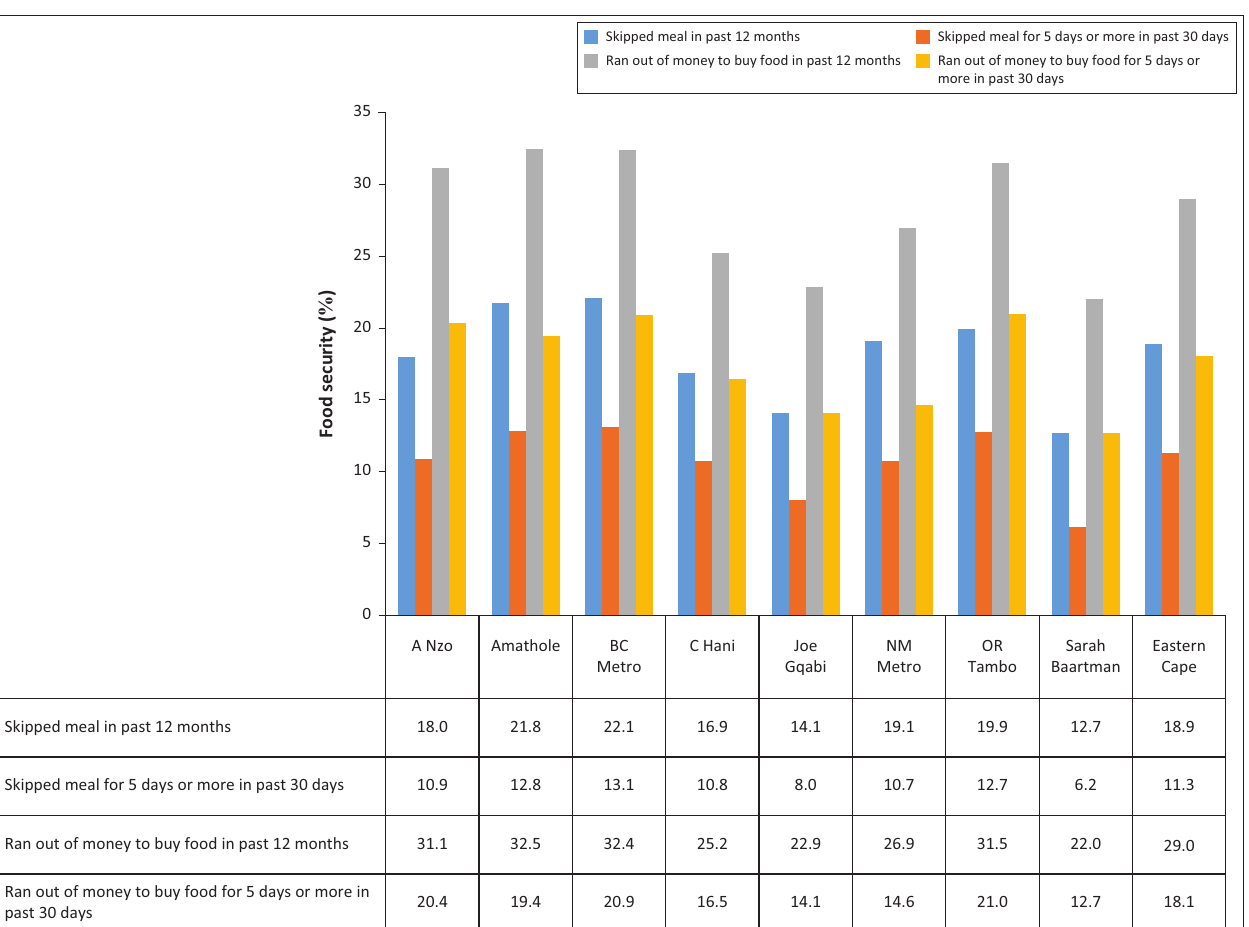
FIG URE 1: The 2017 population pyramid ( N = 6.5 million).